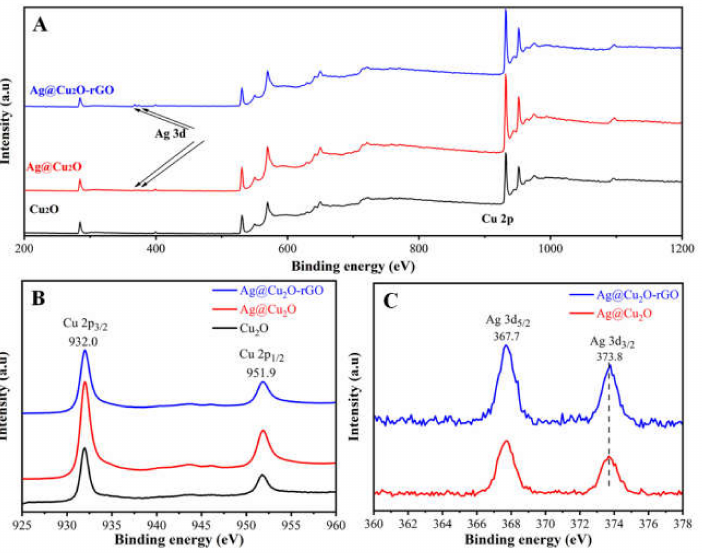
Figure 2. ( A ) The survey XPS, ( B ) Cu 2p, and ( C ) Ag 3d spectra of Cu 2 O, Ag@Cu 2 O, and Ag@Cu 2 O- rGO composite